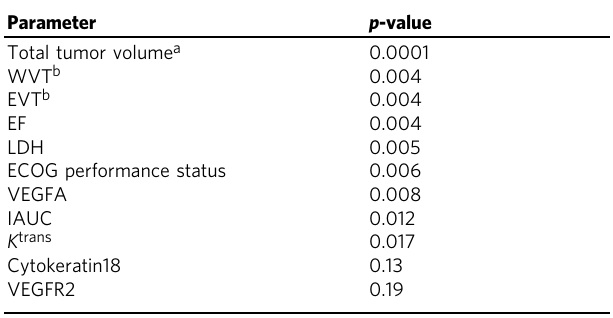
Table 3 Univariate analysis of biomarkers before treatment Parameter p -value